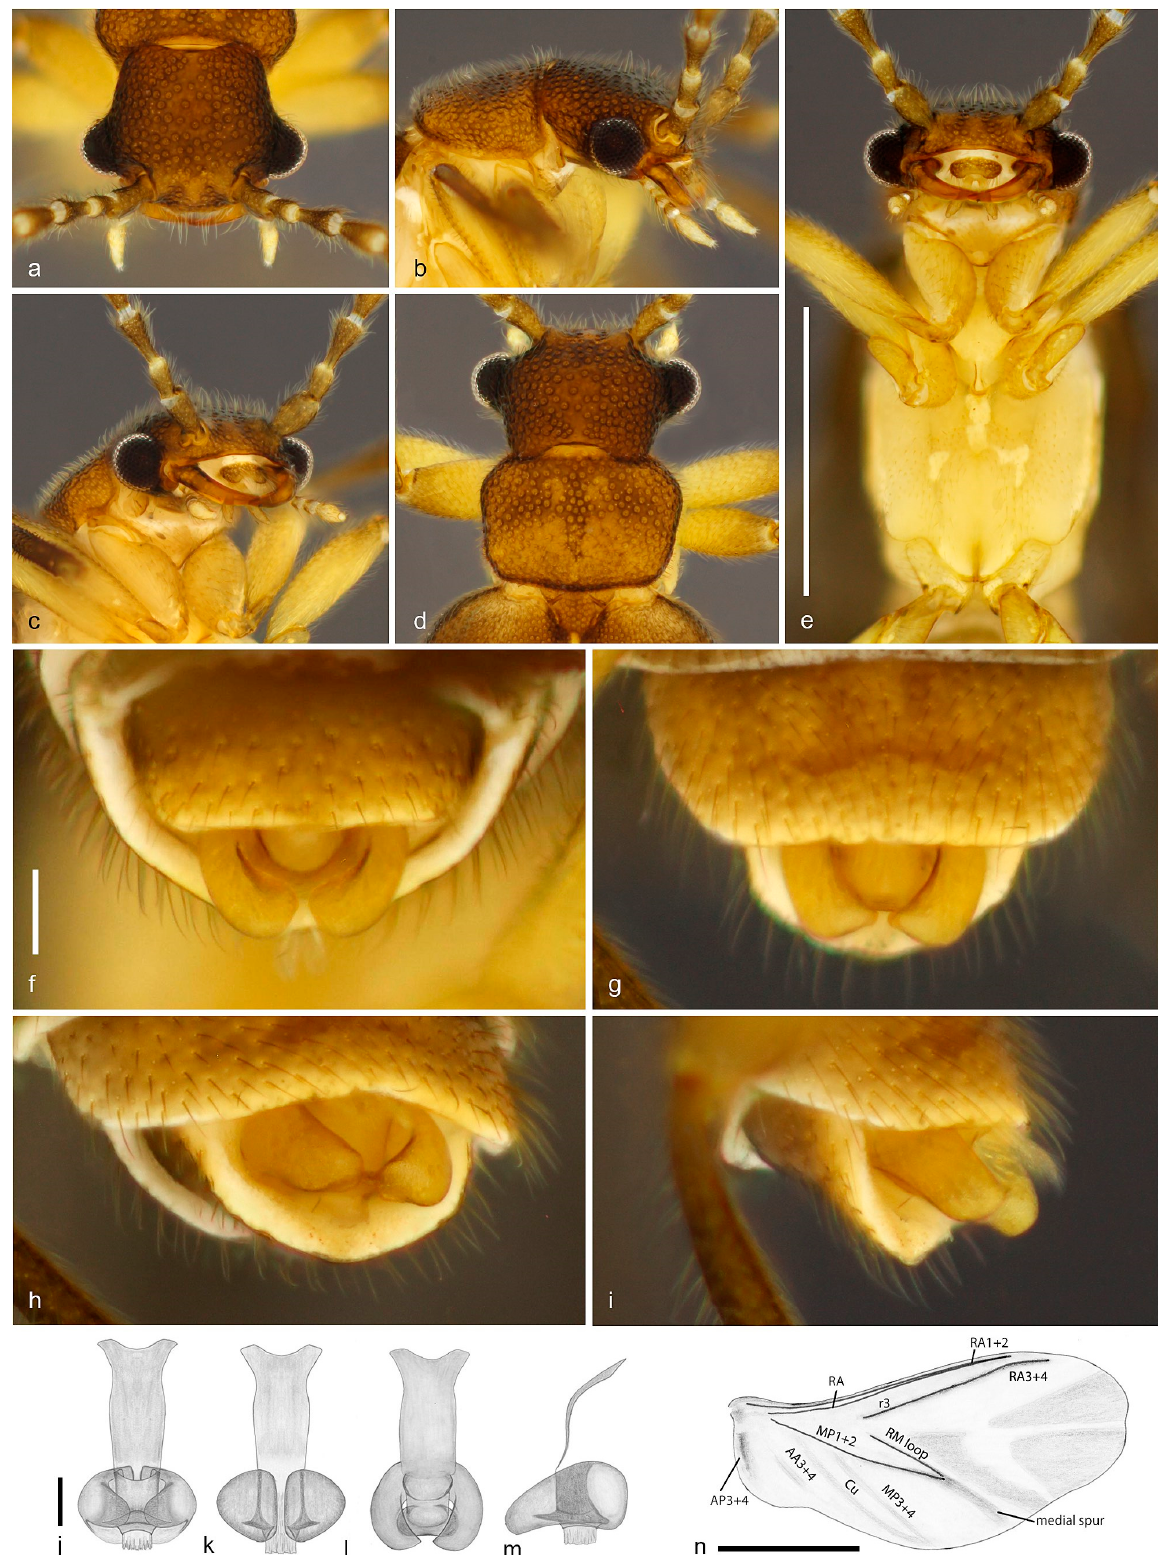
Figure 4. Jurasai vanini sp. nov., details of morphology. ( a ) Head, dorsal view; ( b ) head and prothorax, lateral view; ( c ) head and prothorax, ventrolateral view; ( d ) head and pronotum, dorsal view; ( e ) head, pro-, meso- and metathorax, ventral view; ( f – i ) apex of abdomen; ( f ) posteroventral view; ( g ) ventral view; ( h ) lateroventral view; ( i ) lateral view; ( j – m ) aedeagus; ( j ) ventral view; ( k ) dorsal view; ( l ) anteroventral view; ( m ) lateral view; ( n ) hind wing. Scale bars = 0.5 mm.